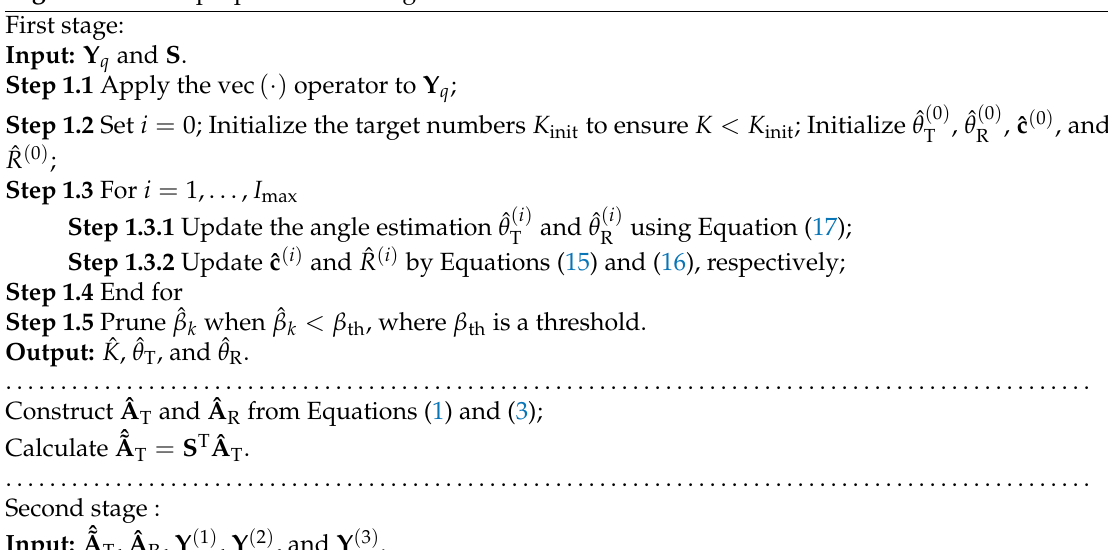
Algorithm 2 The proposed ISR-M